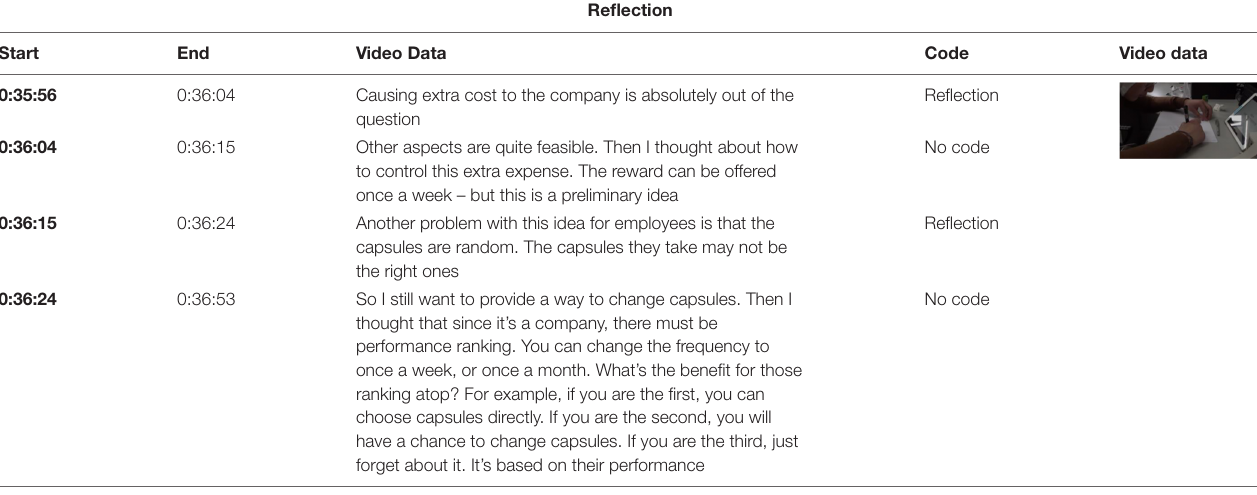
TABLE 3 | Results of retrospective voice coding in reflection stage.